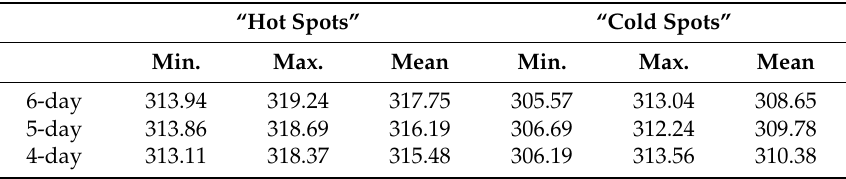
Table 3. LST statistics for the “hot spots” and “cold spots” categories (in ◦ K).